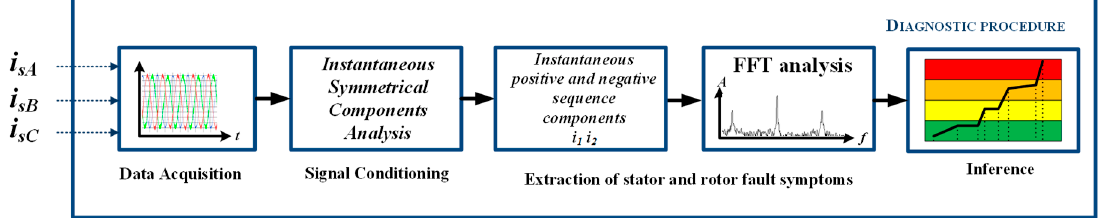
Figure 1. Procedure of stator and rotor fault symptoms analysis using instantaneous symmetrical components of the stator current. FFT: Fast Fourier Transform.